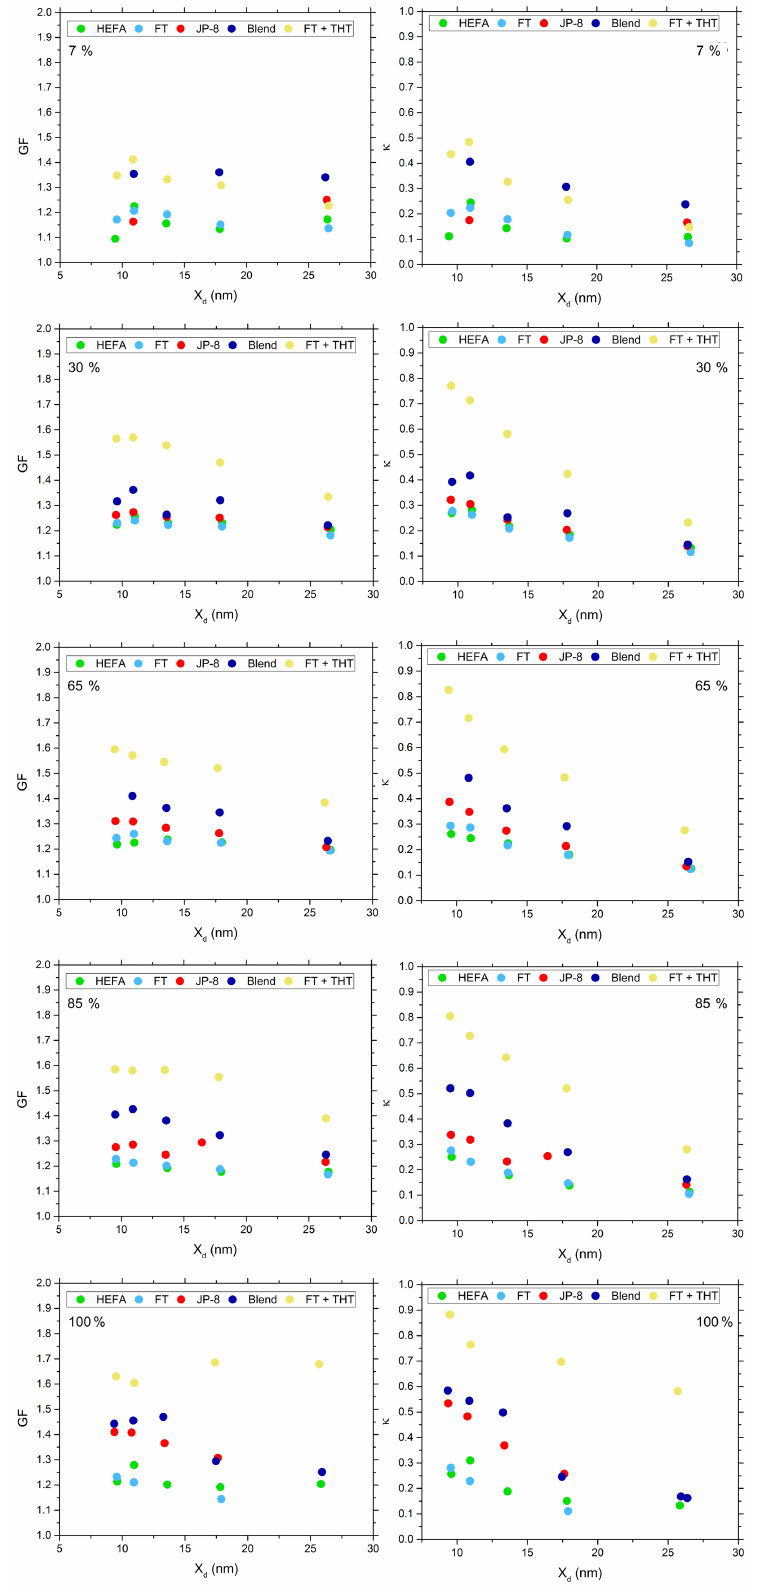
Figure 8. GF and κ as a function of X d for particles generated at different engine thrust conditions and different